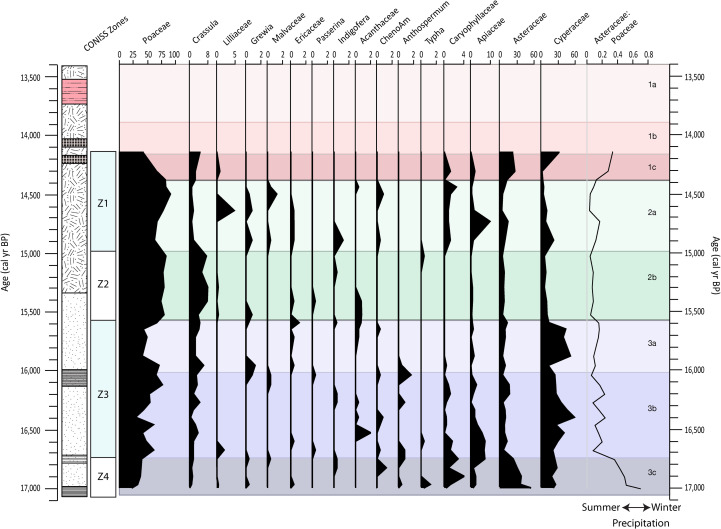
Pollen percentage diagram including the Asteraceae: Poaceae ratio.